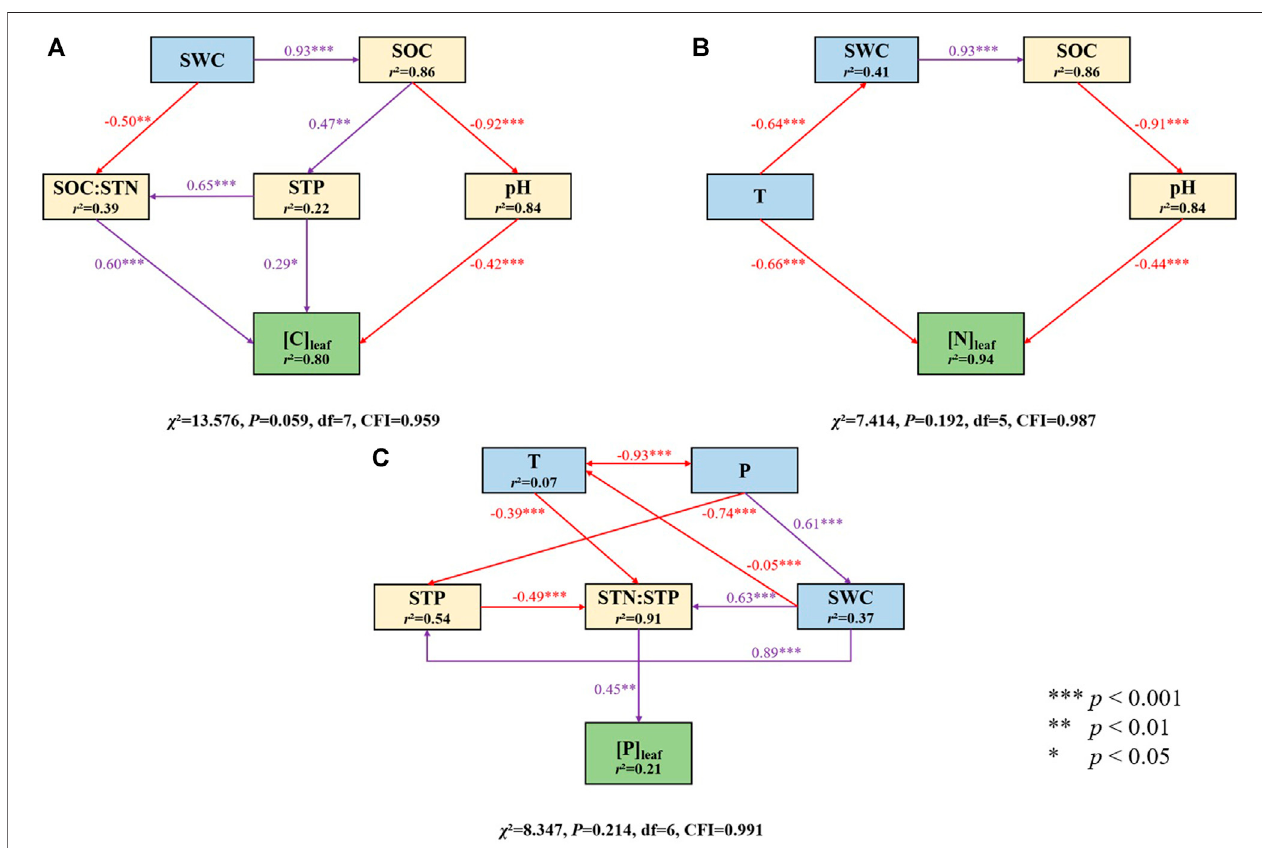
FIGURE 4 | Structural equation model (SEM) showing the direct and indirect effects of SWC, temperature and precipitation on [C] leaf (A) , [N] leaf (B) and [P] leaf (C) . pH, soil pH; SWC, soil water content; SOC, soil organic carbon concentration; STN, soil total nitrogen concentration; STP, soil total phosphorus concentration; [C] leaf , leaf carbon concentration; [N] leaf , leaf nitrogen concentration; [P] leaf , leaf phosphorus concentration; T, temperature; P, precipitation.